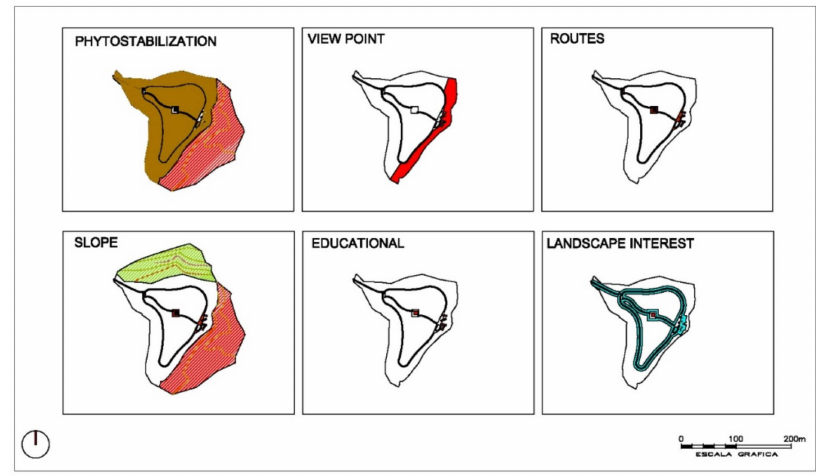
Figure 6. Detailed location of the landscape characterizations by uses, for Case Study 1.